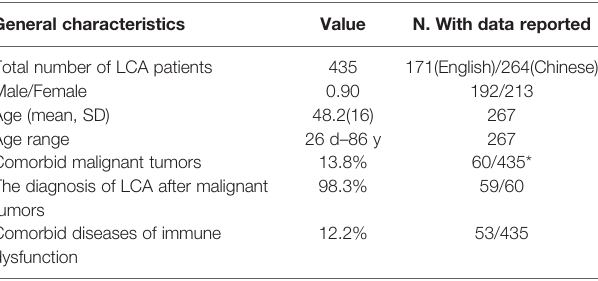
TABLE 1 | General characteristics of LCA population. General